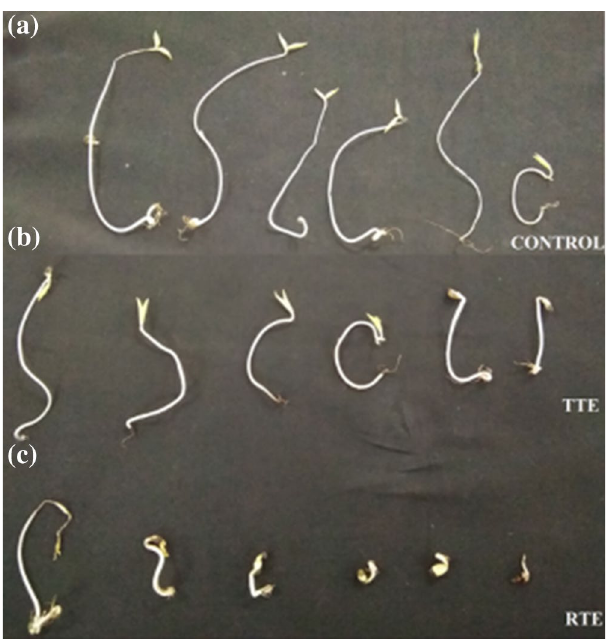
Figure 5. Phytotoxicity analysis of ( a ) Control (Tap water), ( b ) Treated textile effluent, ( c ) Raw textile effluent on P. mungo